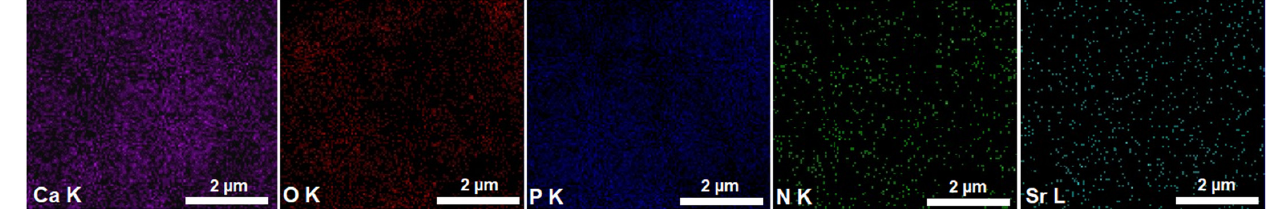
Figure 4. Elemental distribution maps obtained of HAp samples after the decontamination experiments.